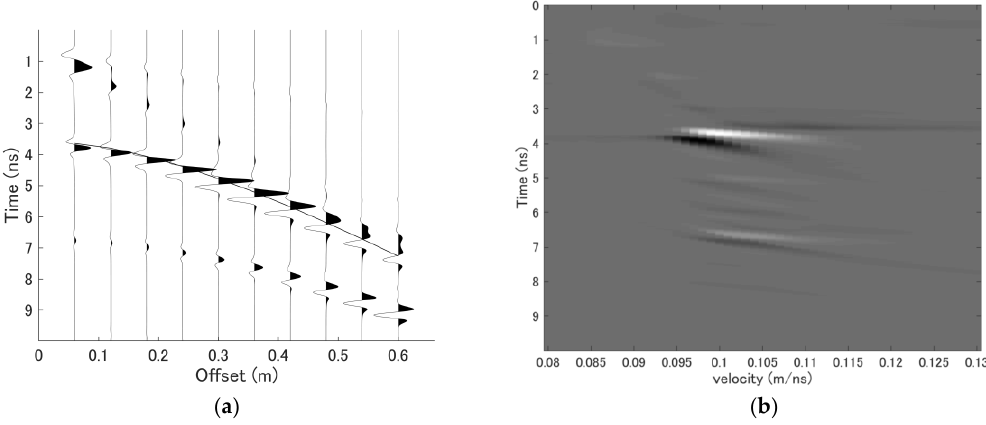
Figure 3. Simulated single-layer CMP dataset and its velocity spectrum. ( a ) CMP dataset for a layer with a thickness of 0.16 m and a propagation velocity of 0.1 m/ns. ( b ) Corresponding velocity spectrum acquired using the stacking method.